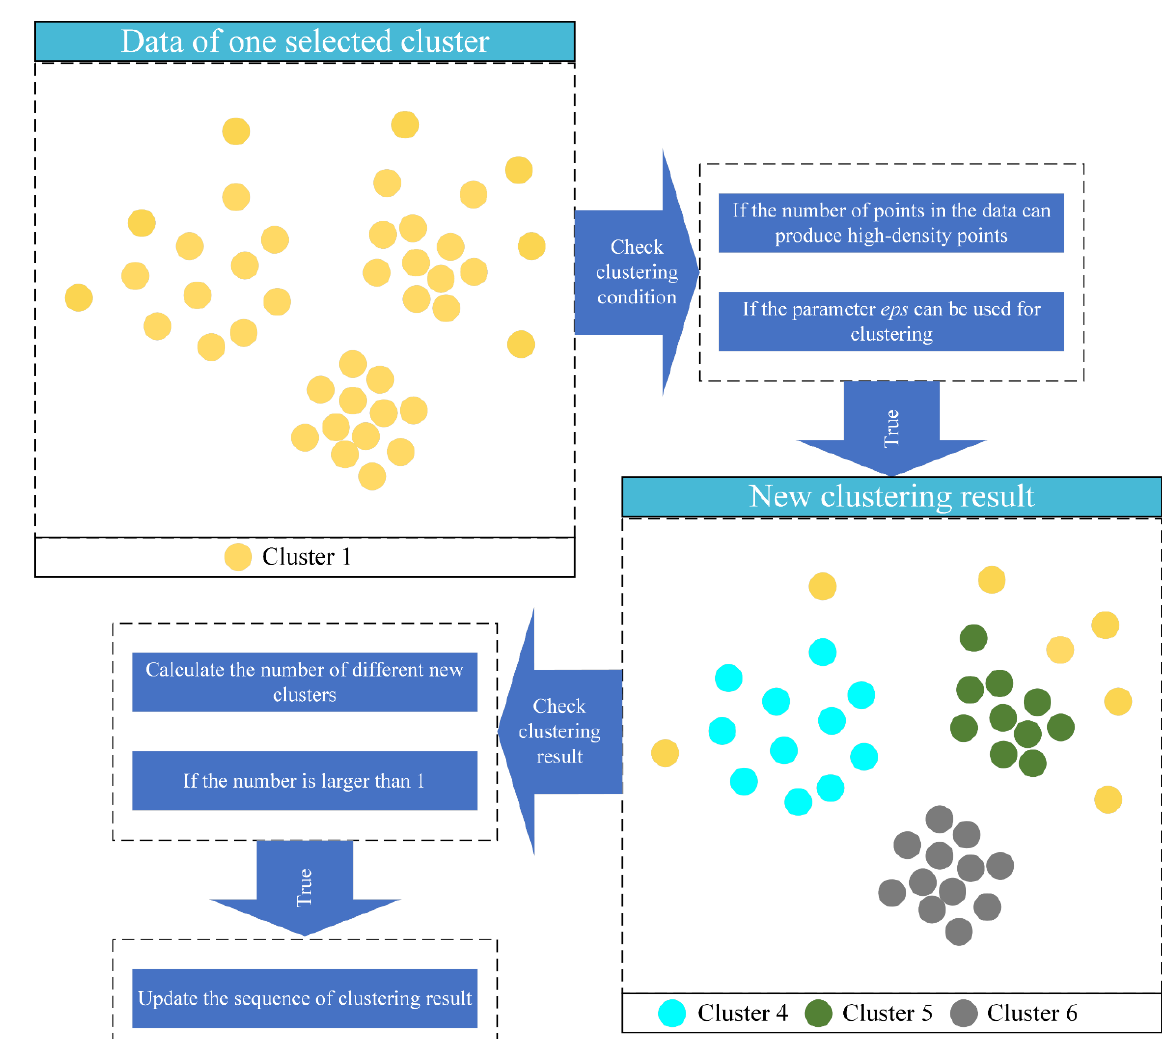
Figure 7. Re-segmentation of one selected cluster, including the check if the data can be clustered and if the clustering result should be used to update the clustering result.